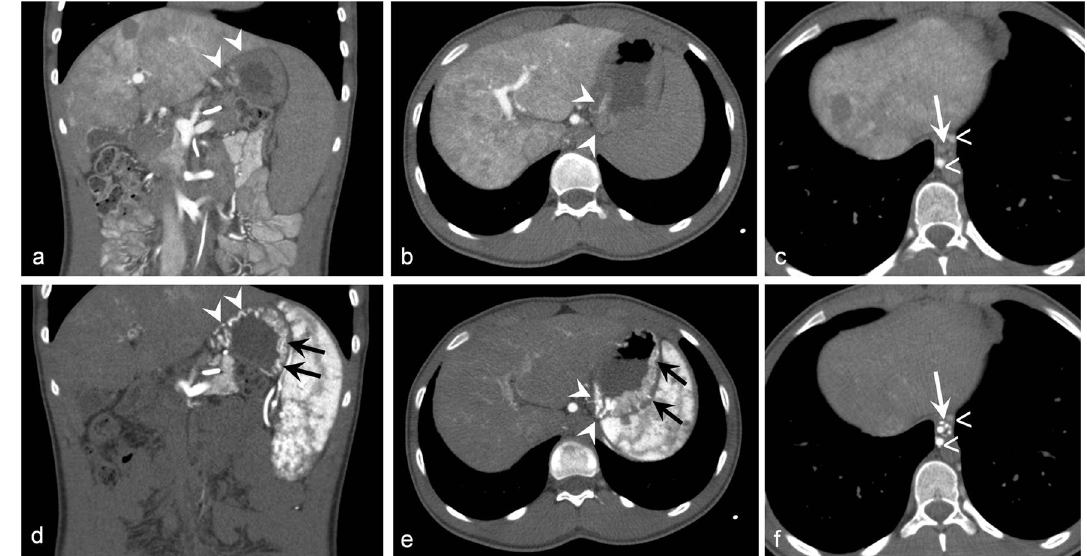
Figure 5. A 15-year-old male patient with PH. Coronal and axial images of CT-AP ( a – c ) and CT-AS ( d – f ). Enhancement of varices of the gastric cardia (arrowheads) and esophagus (white arrows) predmominates in CT-AS ( d – f ) in comparison to CT-AP ( a – c ). Enhancement of paraesophageal varices (open arrows) in both CT-AP ( c ) and CT-AS ( f ). In UEG varices at the gastric cardia were described, CT-AS ( d , e ) delineates additional small fundic varices (black